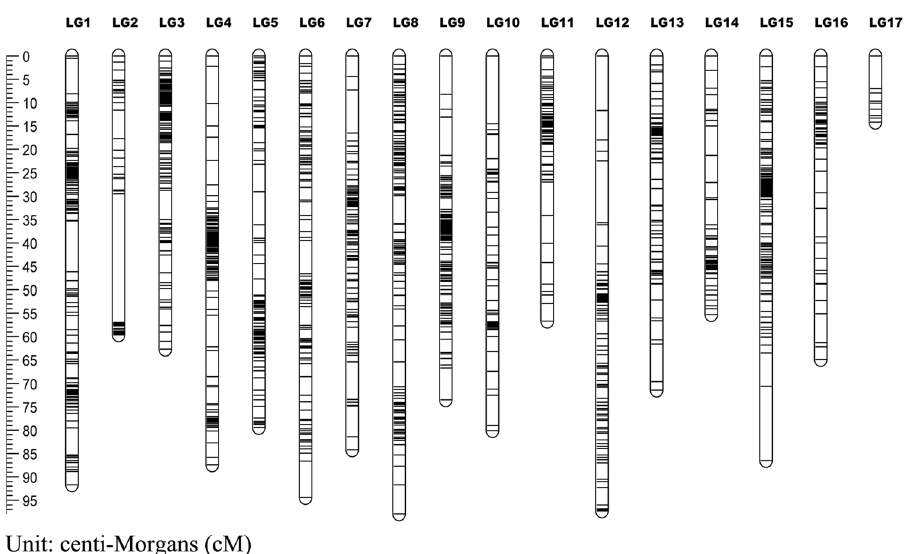
Figure 6. Genetic lengths and marker distribution in 17 linkage groups of pollen parent linkage map. A black bar means a 2b-RAD marker. The left scale plate imeans genetic distance (centiMorgan as